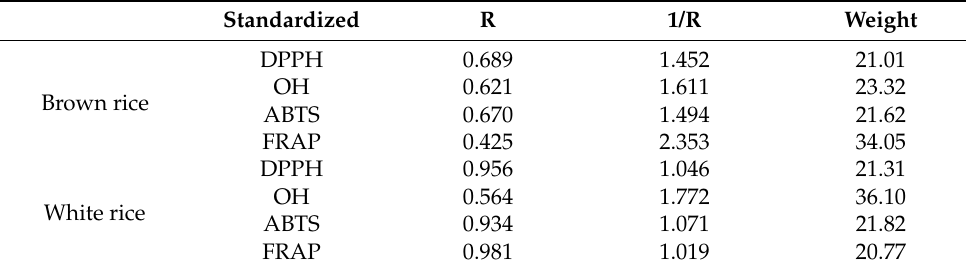
Table 3. Independent weighting analysis of antioxidant